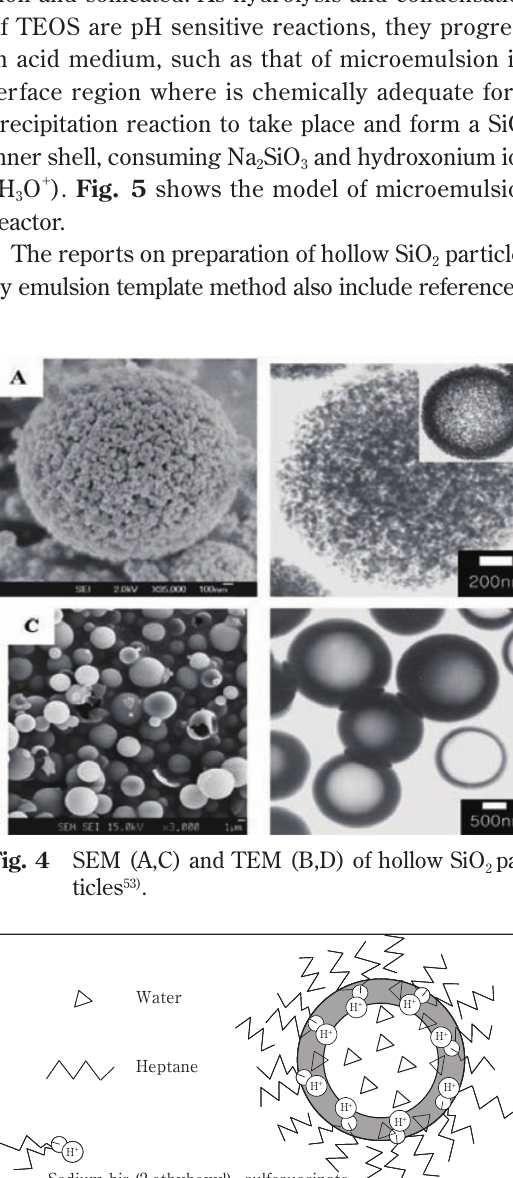
Fig. 5 Schematic representation of microemulsion model 54)